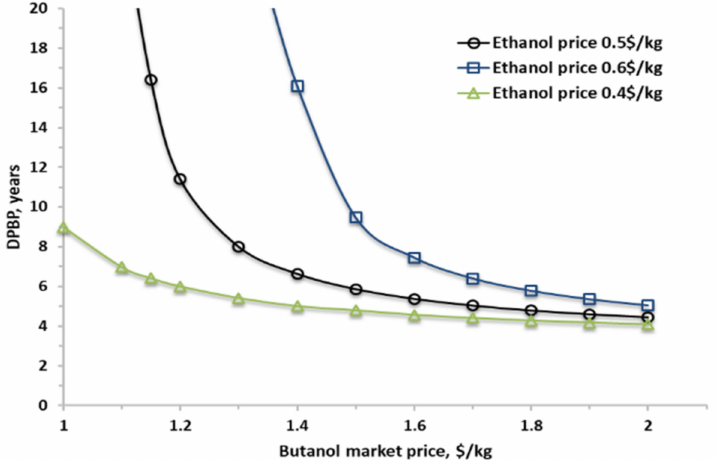
Figure 15. Discount payback period for various butanol and ethanol prices for a plant with a capacity of 80,000 tonnes/y of